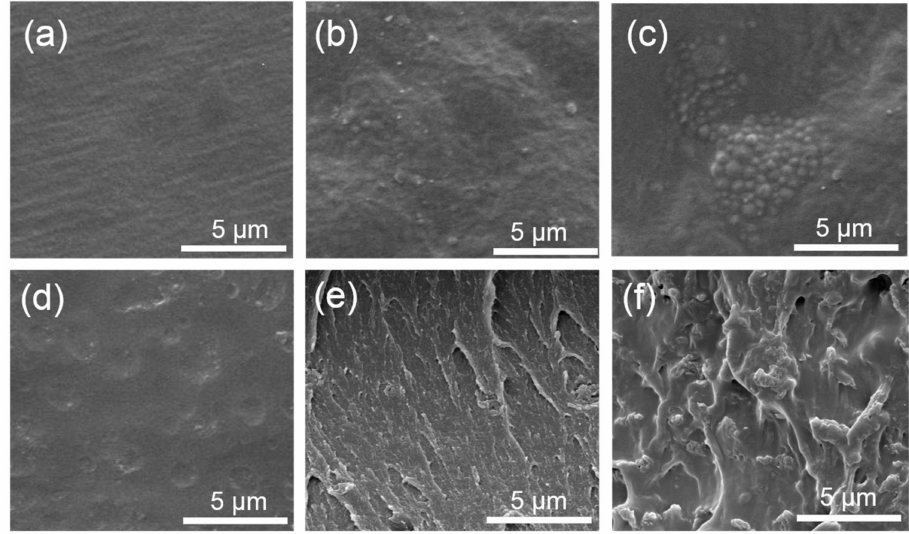
Figure 3. SEM images of surface and cross section of starch film ( a , d ) and SL composite films containing 2% ( b , e ) and 5% ( c , f )